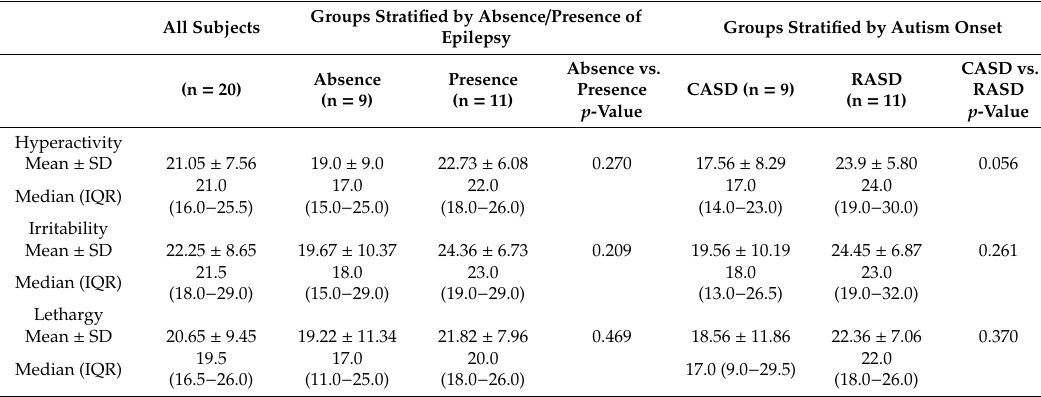
Table 2. Aberrant behavior checklist (ABC) subscales